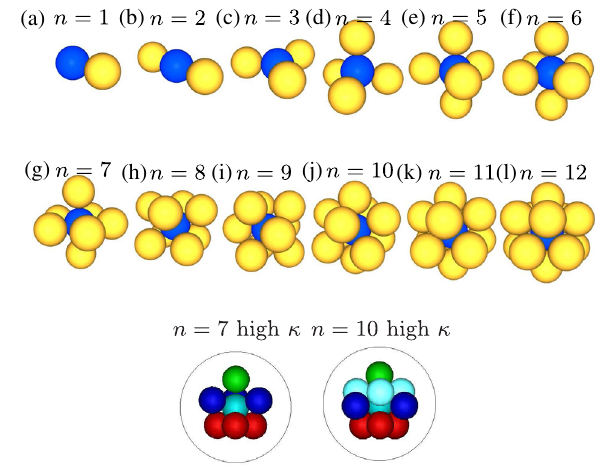
FIG. 5. Optimal configurations for AB n clusters. Negatively charged blue particle and positively charged n ( n ϵ [1,12]) yellow particles are the same size: (a) dimer. (b) line, (c) triangle, (d) tetrahedron, (e) triangular bipyramid, (f) octahedron, (g) pentagonal bipyramid, (h) anticube, (i) triaugmented triangular prism, (j) gyroelongated square bipyramid, (k) irregular, (l) icosahedron. The bottom row shows the alternative clusters found only for short screening lengths (high κ ). (Left) Lowest- energy cluster of 7 particles. A threefold rotational axis of symmetry goes through the (light blue) core particle and the green particle. The other two colors show different equilateral triangles perpendicular to the plane of view. (Right) Lowest- energy cluster of 10